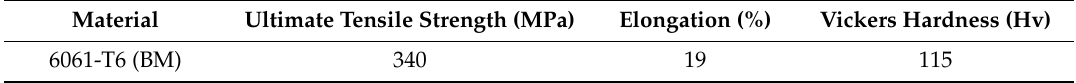
Table 2. Mechanical properties of